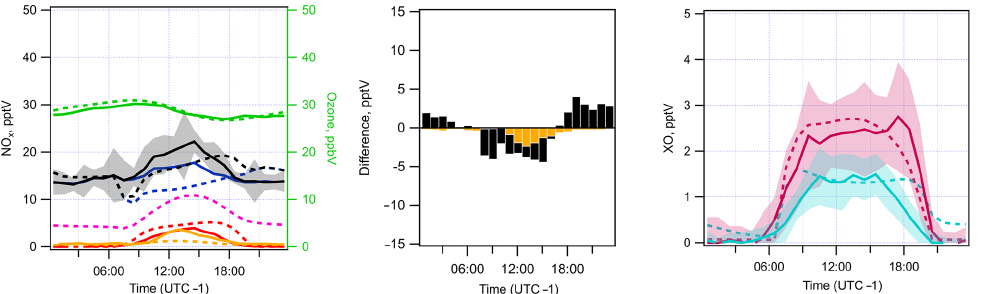
Figure 8. Left is the modelled NO x and HONO diurnal cycle for the CVO site during summer months with the inclusion of night-time HOI chemistry. Centre shows the difference between measured and modelled values of NO x (black) and HONO (yellow). Right is the observed (adapted from Read et al., 2008) and modelled IO and BrO. Observations are solid lines, whilst modelled values are shown dashed. Shaded areas are standard error of the observation. O 3 – green; NO x – black; NO 2 – blue; NO – red; HONO – yellow; PAN – pink; IO – turquoise; BrO – purple.